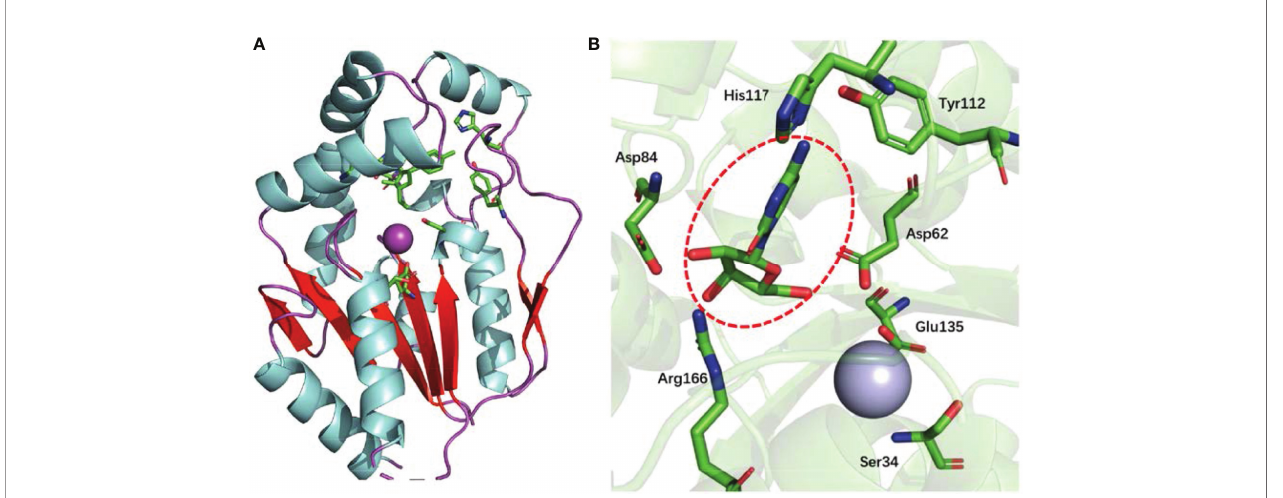
FIGURE 2 | Protein structure of UCK2 and key amino acids for UCK2 ’ s catalytic activity. (A) Ribbon diagram of human UCK2 monomer (PDB code 1UEJ), illustrating binding of cytidine to the active site. The purple sphere indicates a magnesium ion in the active site. The core fi ve-stranded parallel b -sheet and the b -hairpin loop are labeled in red. (B) Stereo view of the active site of UCK2 showing a central bound cytidine (circled with red dashed line). A magnesium ion (cryan sphere) is coordinated by the Asp62, Ser34, and Glu135 at active